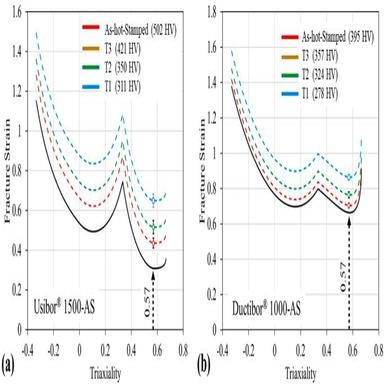
Fracture loci for as-hot-stamped Usibor® 1500-AS and Ductibor® 1000-AS (solid lines adapted from) and HAZ tempered martensite samples using linear interpolation of the BM fracture loci based on measured v-bend strains (dashed lines).